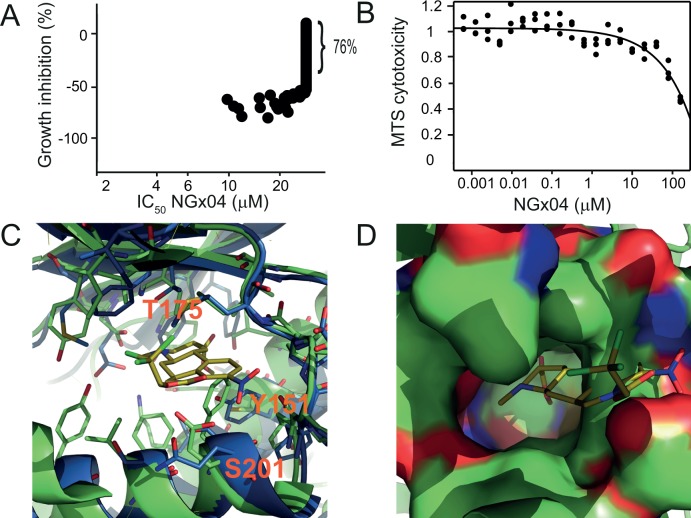
Fungal selectivity.Mammalian cell growth inhibition and cytotoxicity of NGx04. A) Dose-response curves for NGx04 were generated in growth inhibition assay and IC50 values determined in duplicates [39]. IC50 values and growth inhibition (Amax) are displayed. 76% of the tested cell lines were not significantly inhibited by NGx04. B) A dose-response curves for NGx04 was generated in a MTS cytotoxicity assay using HepG2 cells in triplicates and a toxicity curve generated by logistic regression. C) Overlay of the crystal structure of the yeast Sec14p (PDB ID: 1AUA, protein structure highlighted in blue) and its human orthologue SEC14L2 (PDB ID: 1OLM, protein structure highlighted in green) reveals that the amino acid residues belonging to the putative binding site are not conserved between the yeast and the human protein. D) Overlay of the docked NGx04 in the yeast Sec14p (PDB ID: 1AUA) and its human orthologue SEC14L2 (PDB ID: 1OLM). The amino acid residues of the yeast protein structure have been hidden whereas the surface of the putative binding site of the human protein structure has been added to highlight the difference in the overall shape between the active site of the two species.